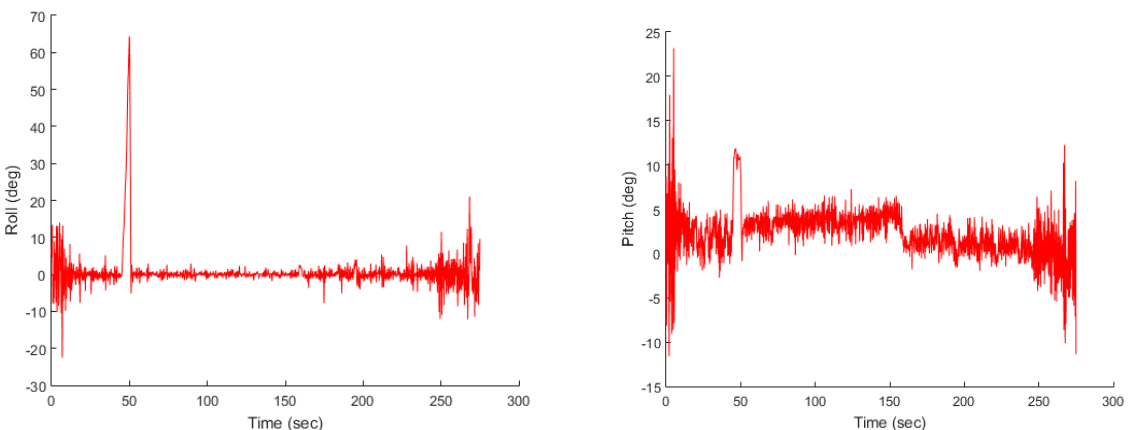
Figure 12. TUP roll and pitch control results.